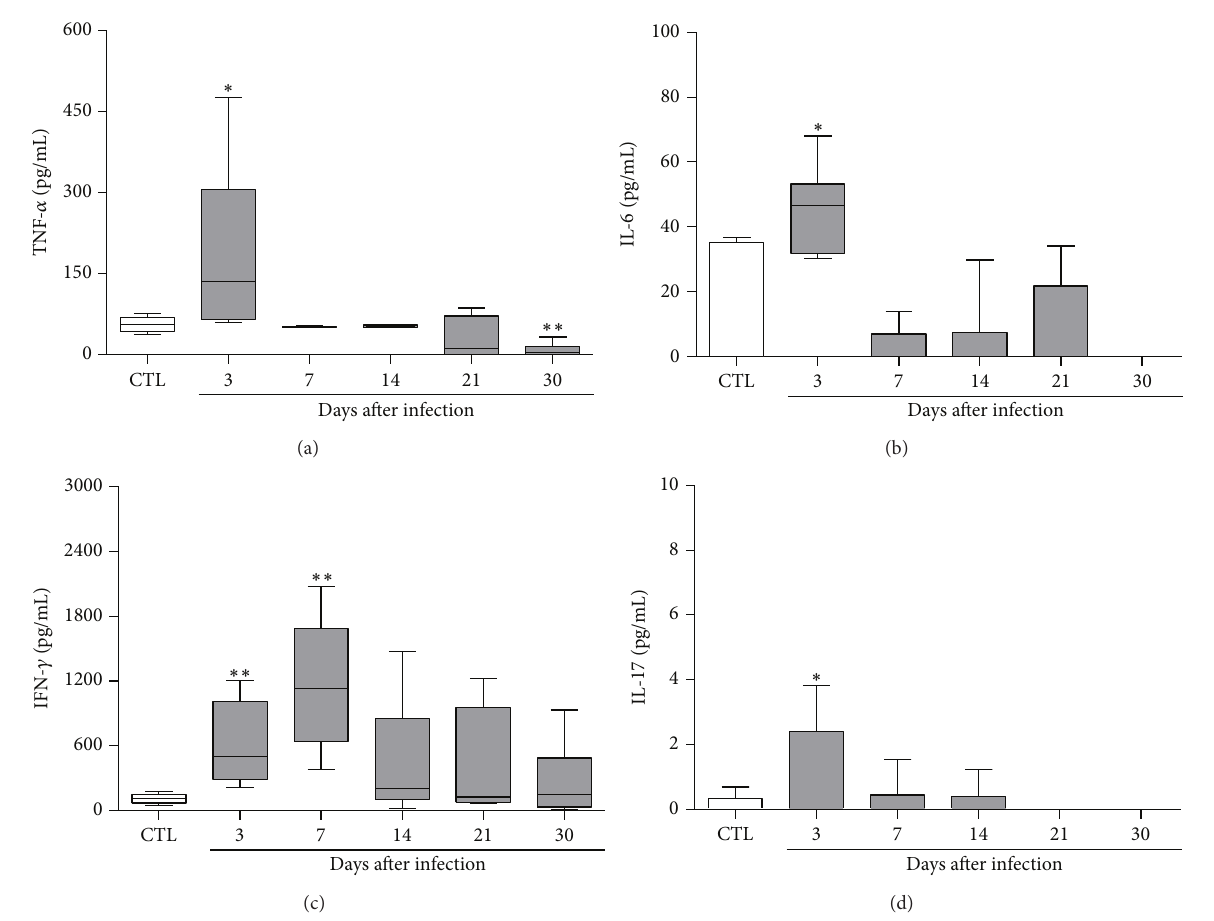
Figure 2: Kinetics of cytokine production by spleen cells from mice infected with C. albicans . C57BL/6 mice were inoculated with C. albicans and the spontaneous production of cytokines by spleen cells was evaluated 3, 7, 14, 21, and 30 days after fungal inoculation. The results are expressed as median, 25–75% (box), and minimum-maximum (error bars) of 5-6 mice/group. Mann-Whitney test, ∗ 𝑃 < 0.05 and ∗∗ 𝑃 < 0.01 indicate statistical difference between each experimental time point and the control group (uninfected).